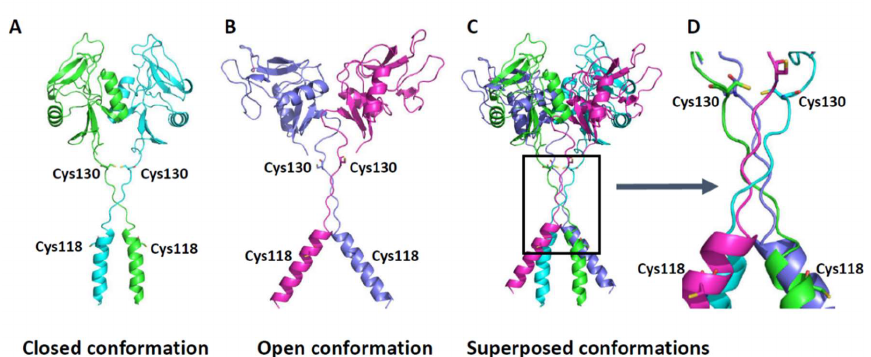
Figure 6. 3D models of CLEC12A in different conformations. ( A ) CLEC12A in closed conformation with Cys118 and Cys130 that could form disulfide bridge between two monomer. ( B ) CLEC12A in open conformation with Cys118 and Cys130 that are predicted to not form disulfide bridge. ( C ) Superposition of closed and open conformation. ( D ) Close-up in the region containing Cys118 and Cys130. 3D models images were generated using PyMOL (http://www.pymol.org) (accesed on 1 February 2016).